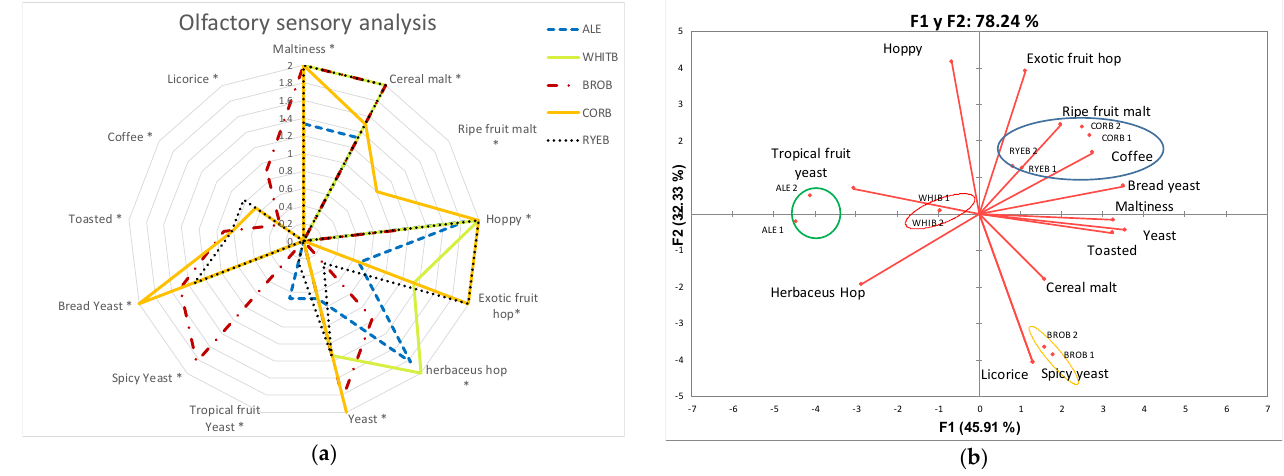
Figure 5. ( a ) Olfactory radar graphic; ( b ) PCA olfactory analysis. * Statistically significant differences ( p ‐ value ≤ 0.05).